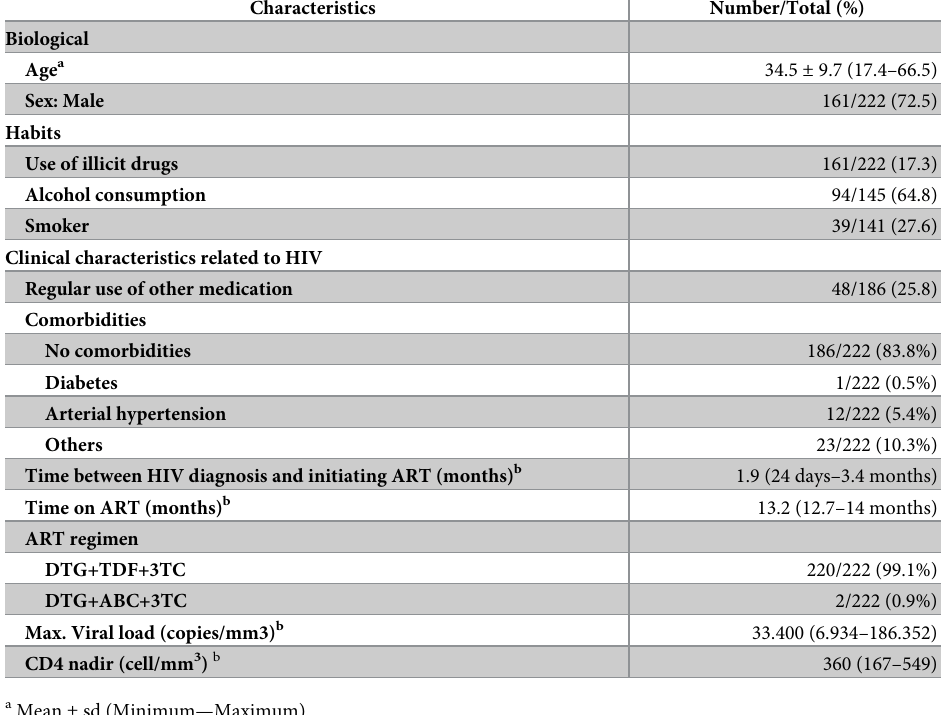
Table 1. Biological, clinical and behavioural characteristics of 222 people living with HIV who initiated the first antiretroviral regimen containing